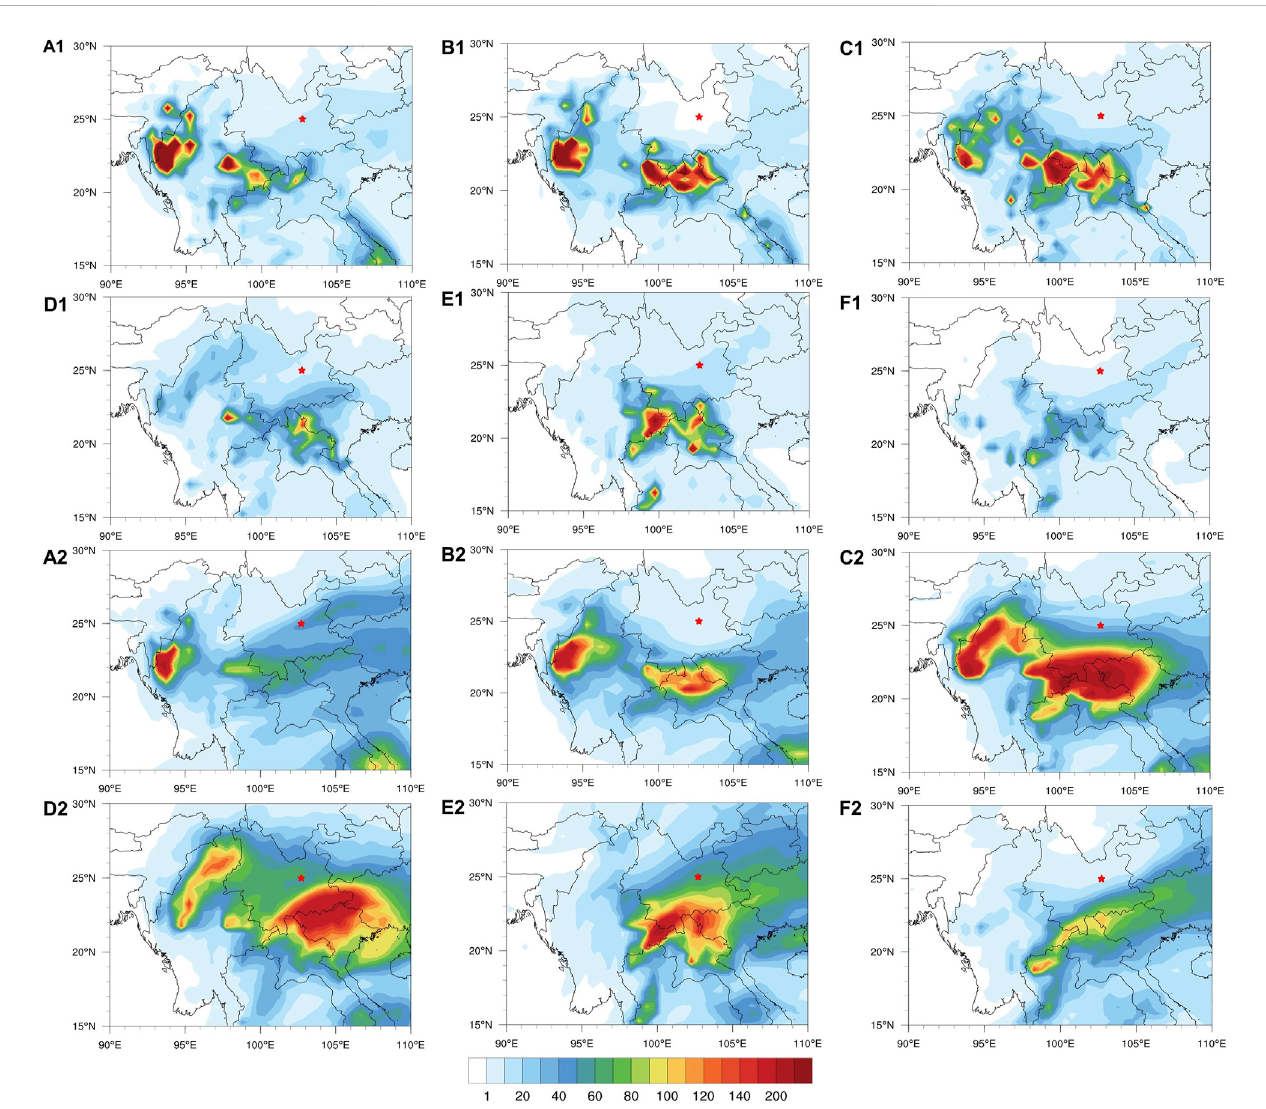
FIGURE 10 The model simulated daily mean (A1 – F1) near surface PM 2.5 concentrations ( μ g m − 3 ) and (A2 – F2) PM 2.5 column concentrations (mg m − 2 ) in the troposphere produced by biomass burning in Southeast Asia from 28 March to 2 April 2019 (A – F) . The red stars denote the location of Kunming